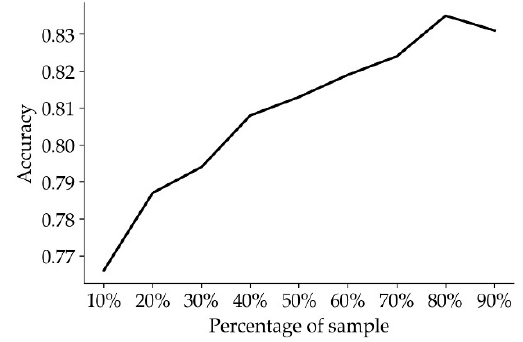
Figure 7. E ff ect of the sample size on the model Figure 7. Effect of the sample size on the model accuracy.